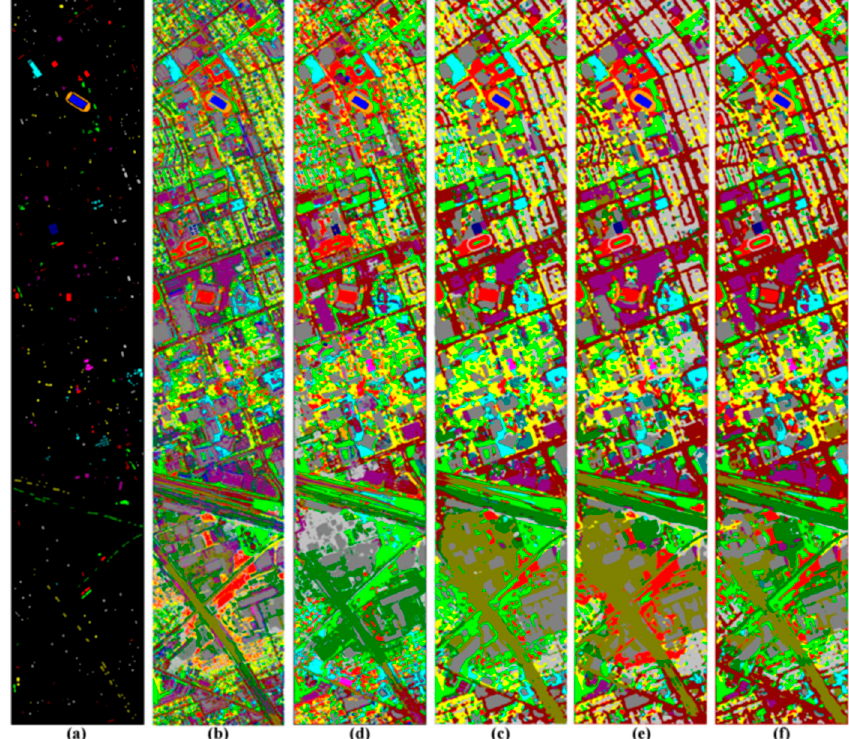
Figure 13. Classification results obtained from the Houston data set using different methods. ( a )